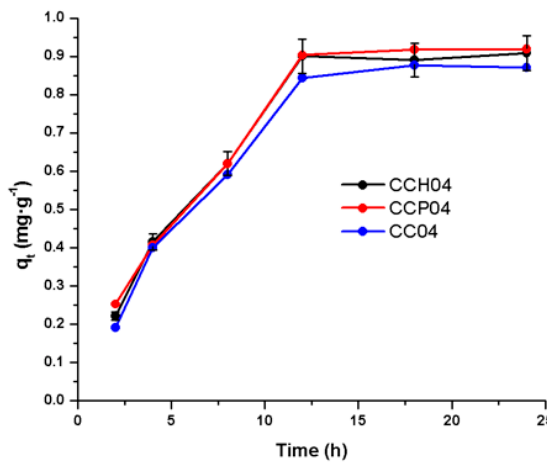
Figure 10. Adsorption kinetics for the synthesized materials: CC04 copolymer, and CCH04 and CCP04 nanocomposites.